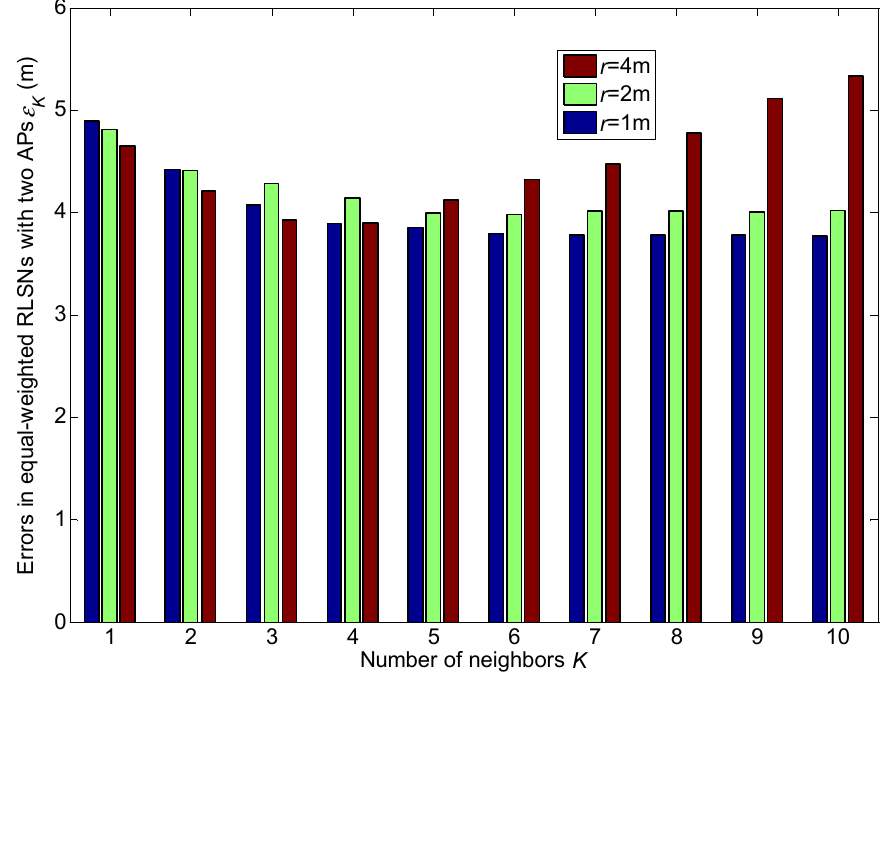
Figure 17. Localization errors in equal-weighted RLSNs with two APs (AP1 and